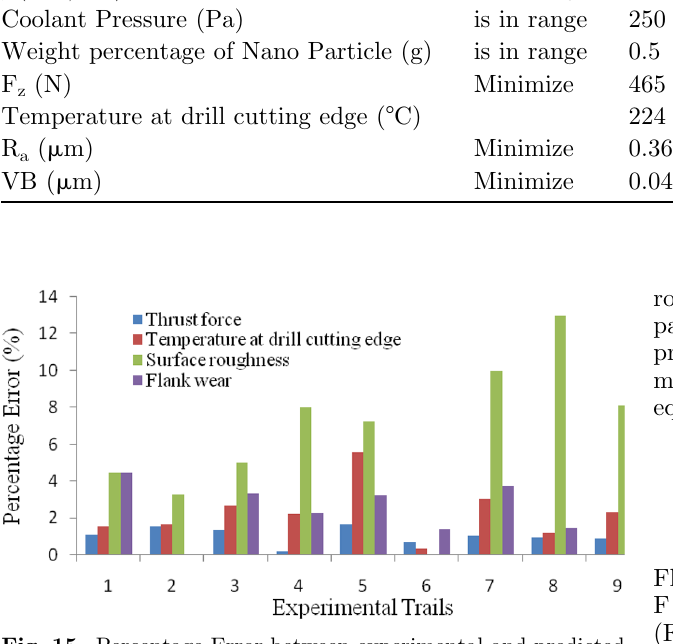
Fig. 15. Percentage Error between experimental and predicted values.